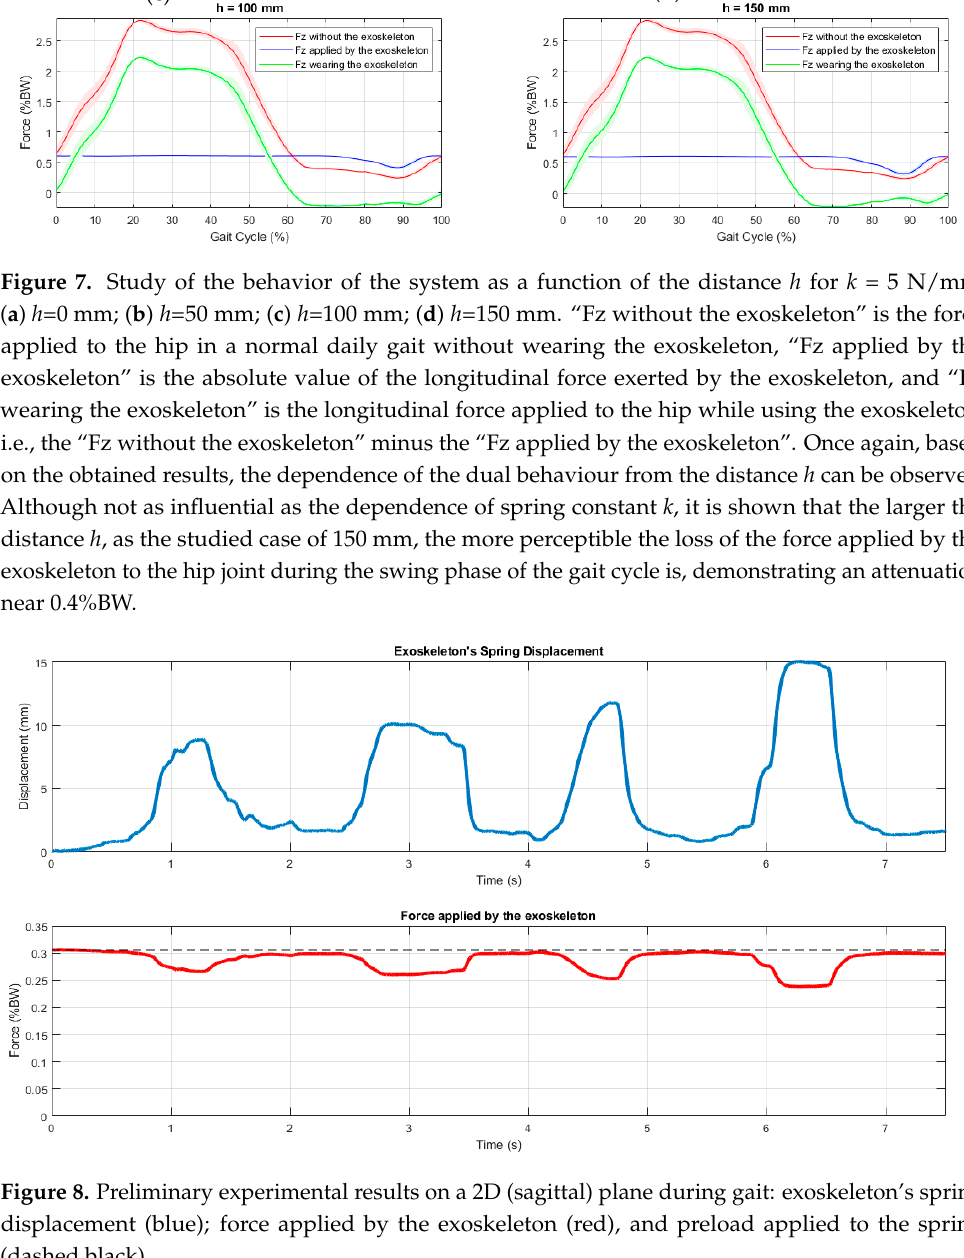
Figure 8. Preliminary experimental results on a 2D (sagittal) plane during gait: exoskeleton’s spring displacement (blue); force applied by the exoskeleton (red), and preload applied to the spring (dashed black).